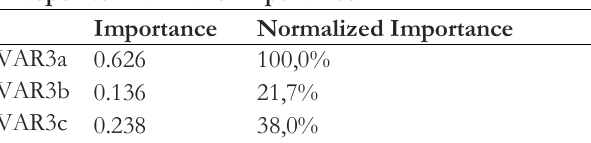
Table 7. Independent variable importance for classical item 3 in terms of neutrosophic items.